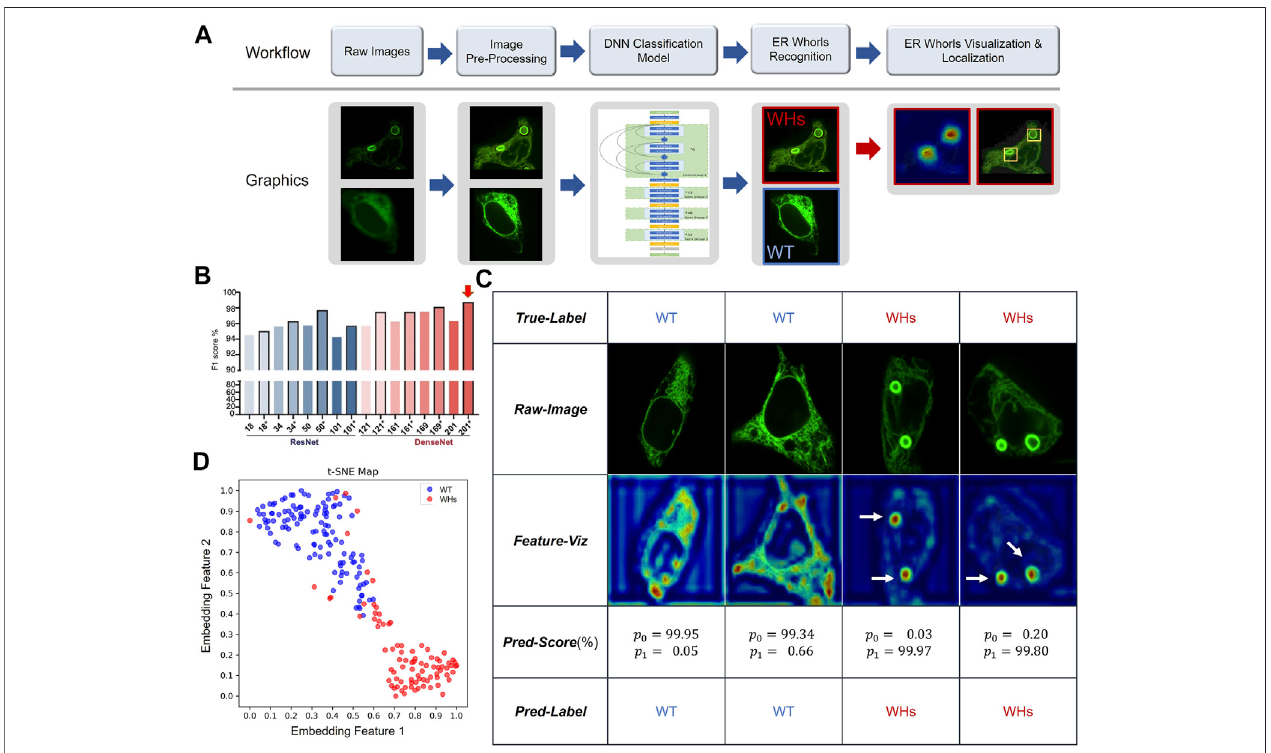
FIGURE 5 | Deep learning-based morphological classi fi cation of ER morphology. (A) Overall work fl ow of the proposed ER-WHs-Analyzer. (B) Performance evaluation of various DNNs-based classi fi cation models in the feature recognition module of ER-WHs-Analyzer. * indicates that the model was fi netuned from a pre- trainedmodel.Numberson X axisindicatedifferentdepthofthedeeplearningmodels.Redarrowindicatesthebestperformedmodel,theDenseNet-201whichconsists of 201 weights-learnable layers. (C) Results of images from the ER-Stress-A dataset processed by ER-WHs-Analyzer-v1, including the raw images, their corresponding feature heat maps, their prediction scores, and their predicted labels. (D) Based on the phenotypic features learned, a t-SNE map was used to visualize the distribution of wildtype ER images (WT) and the ER images with whorls